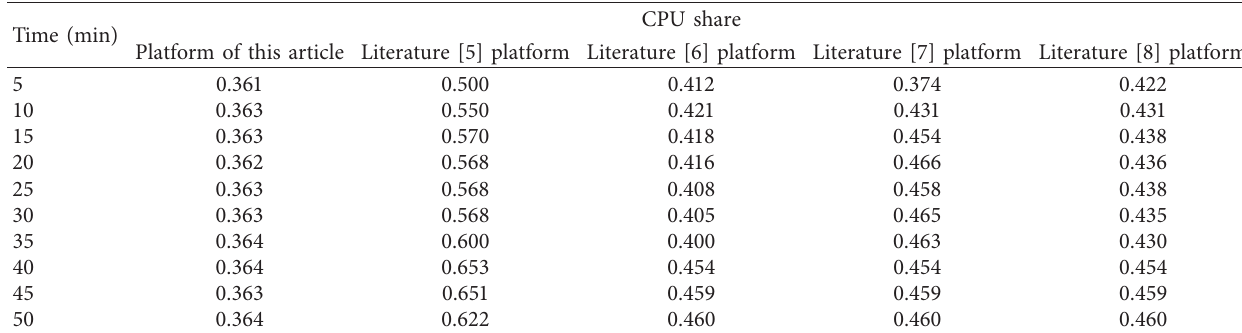
Table 3: Comparison of CPU occupancy of all platforms.